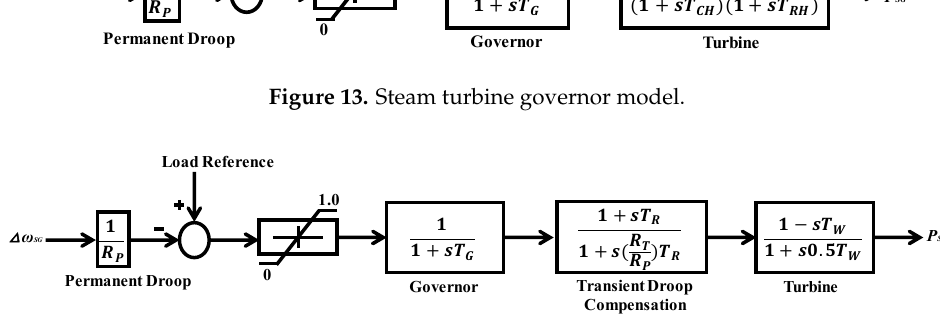
Figure 14. Hydro turbine governor model.